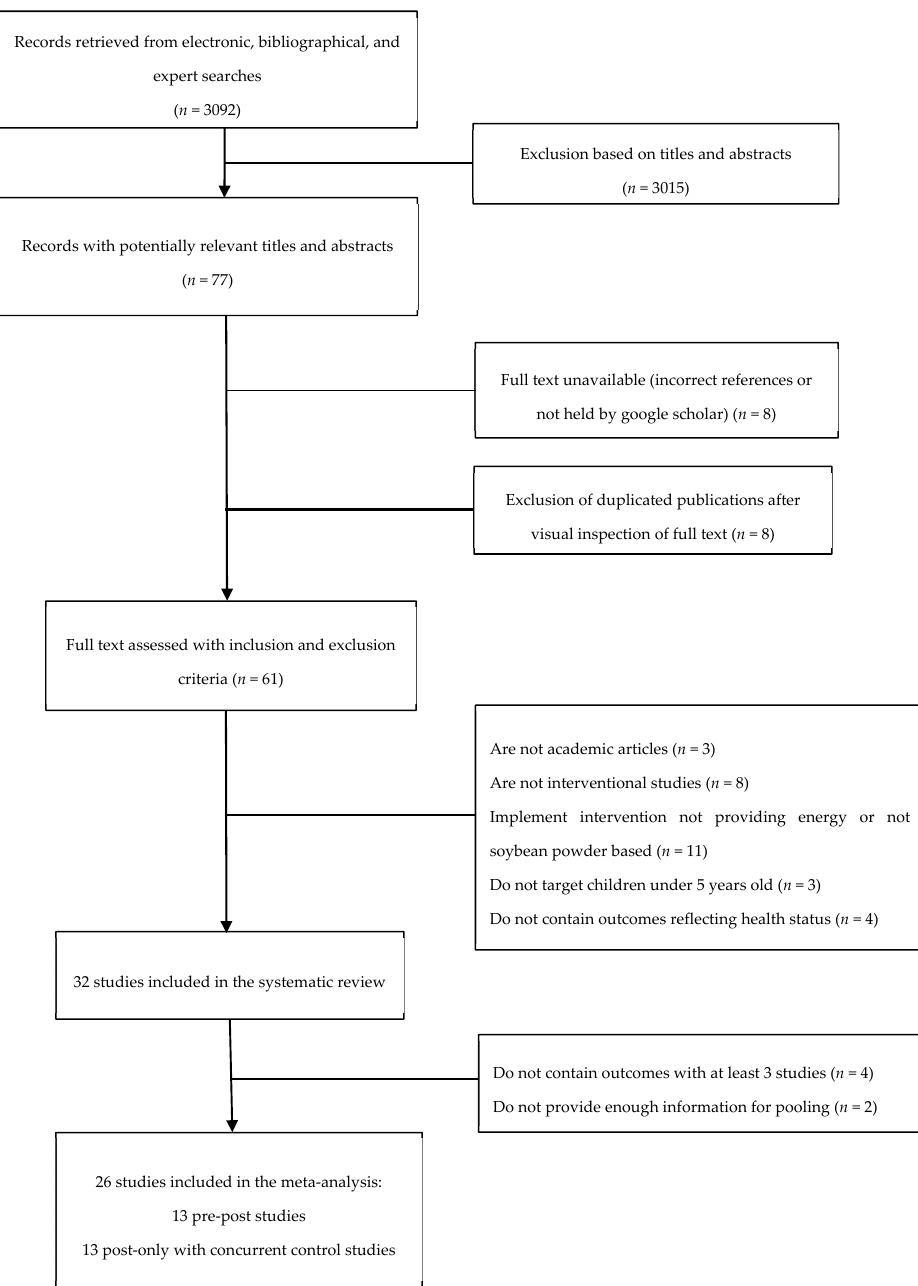
Figure 1. Flow diagram of search and selection process.